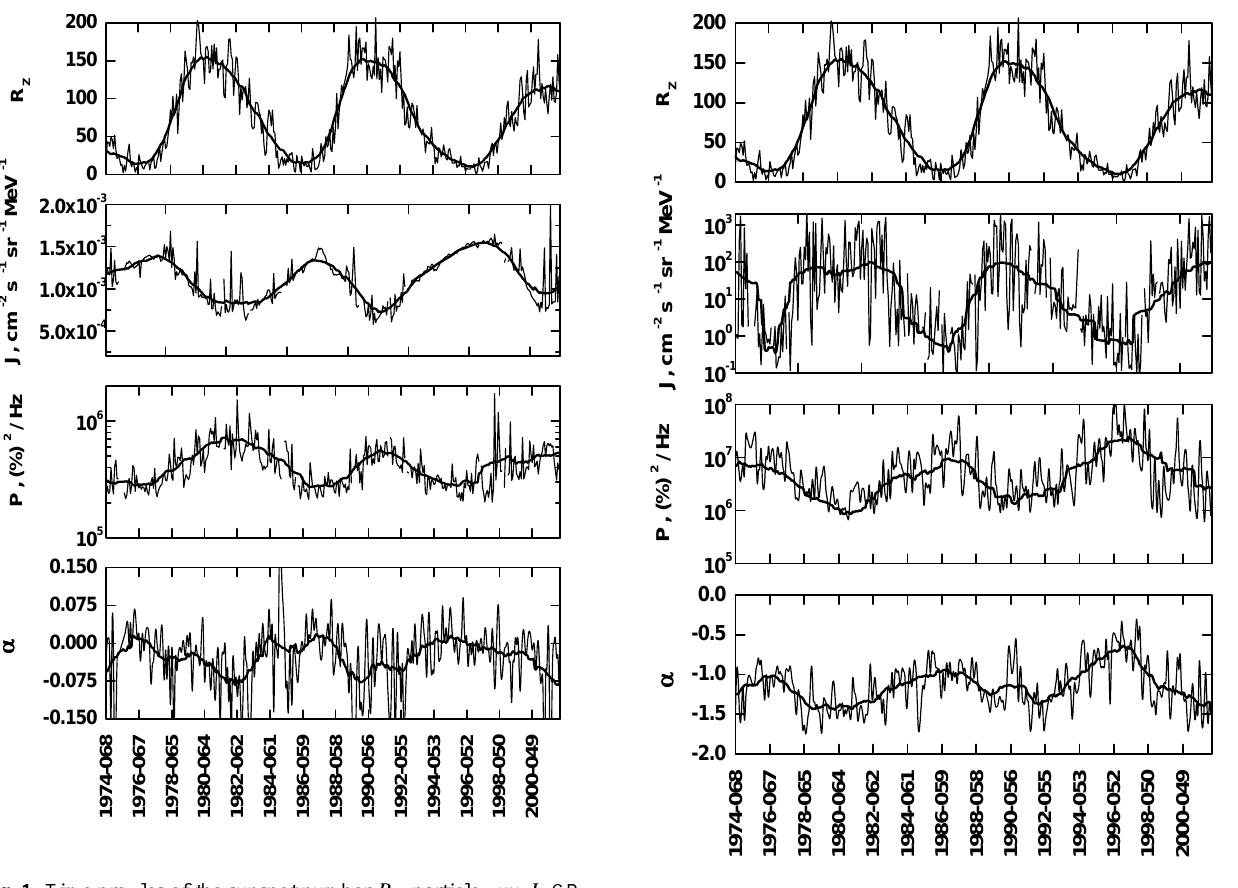
Fig. 2. The same as Fig. 1 but for IMP-8/CPME channel P2